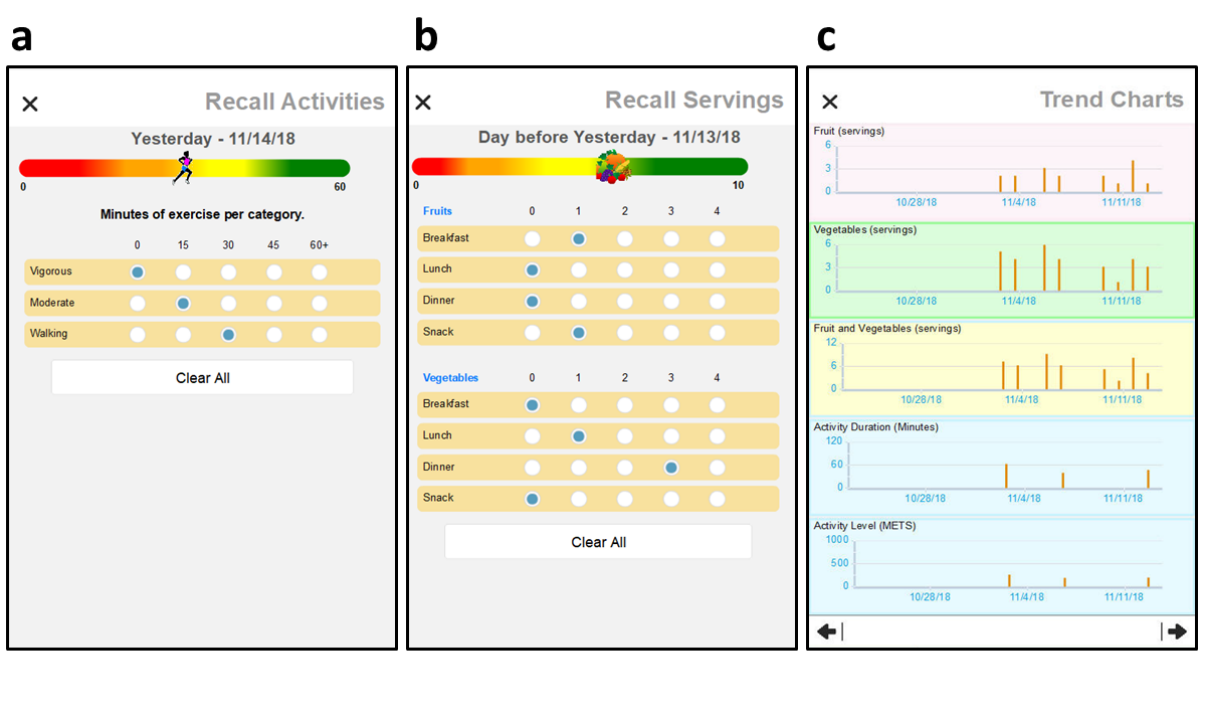
Figure 3. Example diary entry screens for daily tracking of fruit & vegetable consumption (a) and physical activity (b). Trend charts provide feedback on behavior goals over three weeks of recent entries (c).